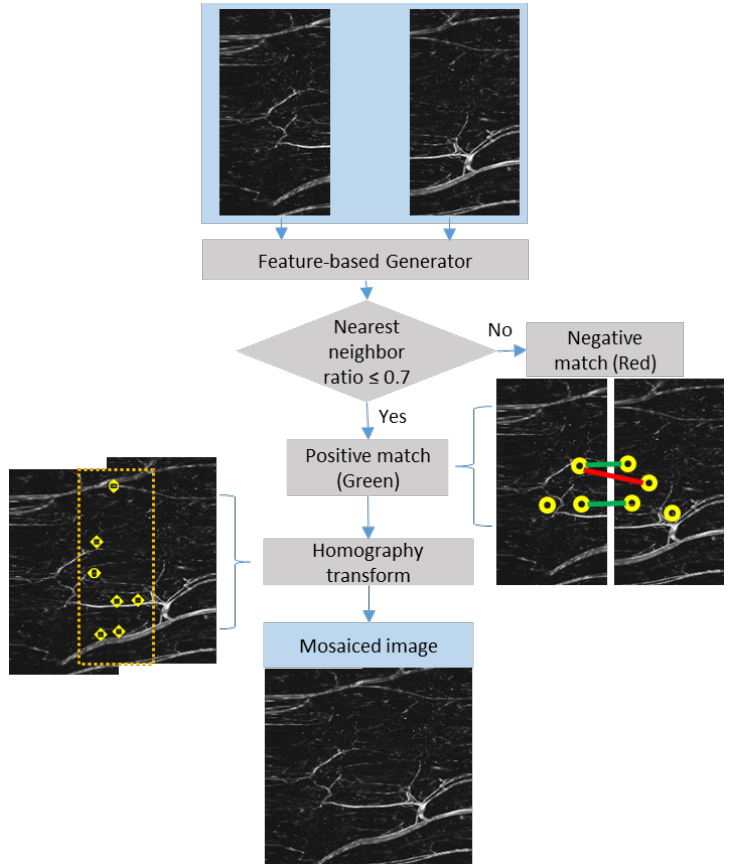
Figure 3. Flowchart of the mosaic PAM imaging generation.